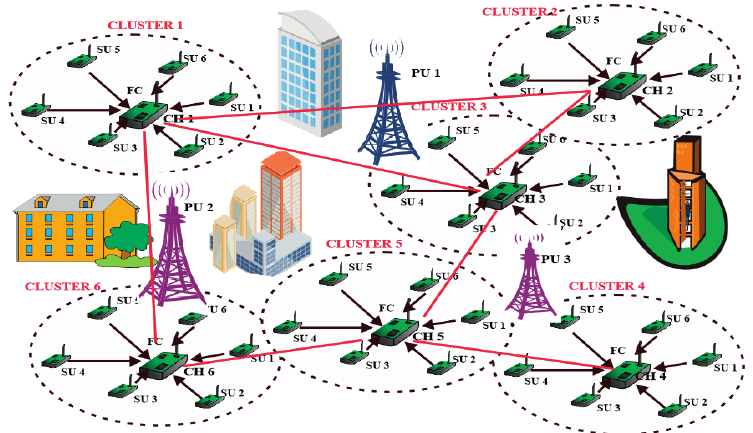
Figure 1. Clustered cooperative channel